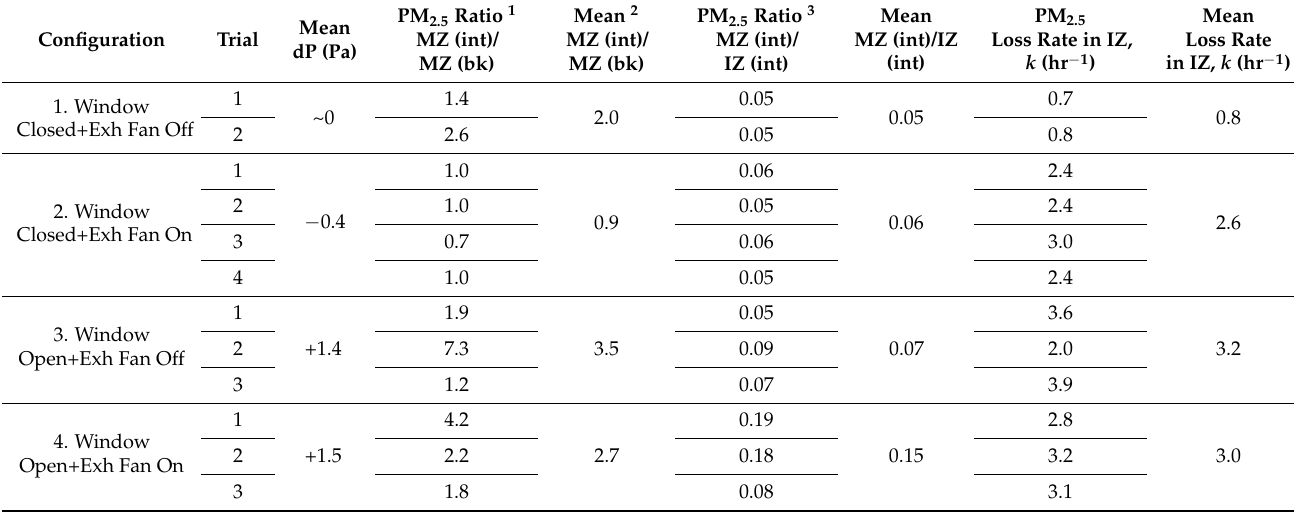
Table 1. Statistical Summary of Pressure Differential (dP) and PM 2.5 Test Results.